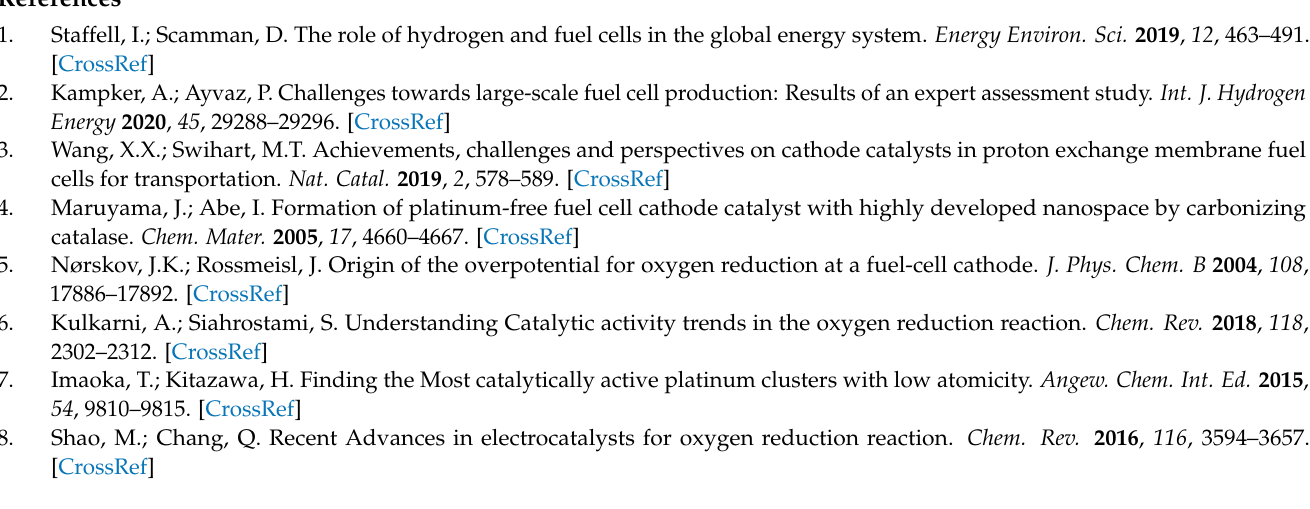
Figure S2: XRD patterns of PtNi nanocrystals and Vulcan XC-72; Figure S3: HRTEM image of the initial Pt/C; Figure S4: XRD patterns of G-PtNi/C-200 nanocrystals; Figure S5: The ORR polarization curves of PtNi/C-150, PtNi/C-170, PtNi/C-190, and PtNi/C-200 catalysts were conducted in 0.1 M KOH with saturated oxygen; Figure S6: XRD patterns of PtNi/C-3: 1, PtNi/C-2: 1, PtNi/C-1: 1, PtNi/C-1: 2, and PtNi/C-1: 3 nanocrystals; Figure S7: The ORR polarization curves of Ni/XC-72, Pt/XC-72, PtNi/C-3: 1, PtNi/C-2: 1, PtNi/C-1: 1, PtNi/C-1: 2, and PtNi/C-1: 3 catalysts were conducted in 0.1 M KOH with saturated oxygen; Figure S8: The CV curves of PtNiC-200 catalysts; Figure S9: The ORR polarization curves of PtNi/Ketjen Black and PtNi/XC-72 catalysts were conducted in 0.1 M KOH with saturated oxygen; Figure S10: The ORR polarization curves of G-PtNi/C-200, PtNi/C-200 in O 2 -saturated 0.1 M KOH; Figure S11: ECSA of commercial Pt/C and PtNi/C-200 at 0.9 V (vs. RHE); Figure S12: Nyquist plots of PtNi/C-200 and commercial Pt/C; Figure S13: Long-term stability of commercial Pt/C (5 wt.%) catalyst; Table S1: ICP-OES results for various PtNi/C samples; Table S2: Fitting data of EIS results of commercial Pt/C-20% and PtNi/C-200 in 0.1 M KOH; Table